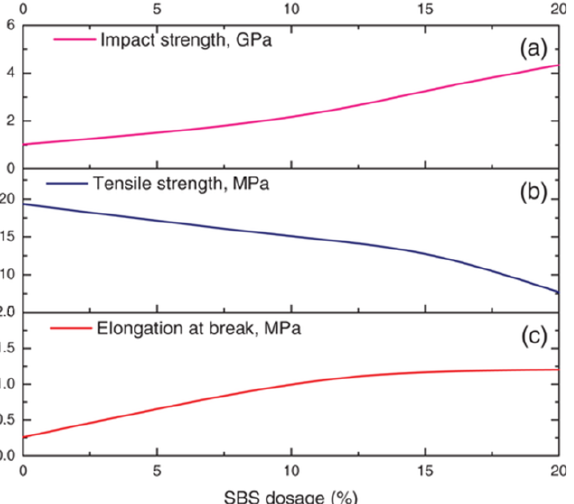
Figure 35. Variation in mechanical properties of WEEE composites with 0 – 20% SBS ( a ) Impact strength, ( b ) Tensile strength, ( c ) Elongation at break. Reprinted with permission from ref. [101].